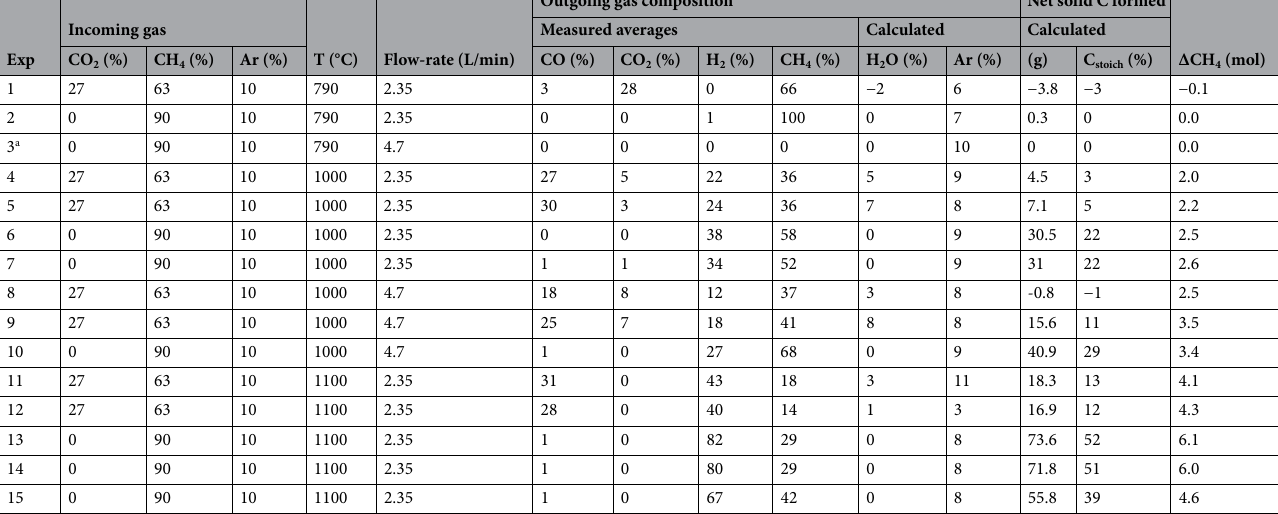
Table 2. Measured (µ-GC) and calculated (from mass balance) composition of off-gas and amount of solid carbon formed for all experiments. C stoich means percentage of carbon necessary for self-reduction of all MnO (see text). Note that carbon formed does not equate to carbon deposited . ΔCH 4 is the difference, in mol, between incoming and outgoing methane. a In Experiment 3, an error occurred which gave no signal to the off-gas